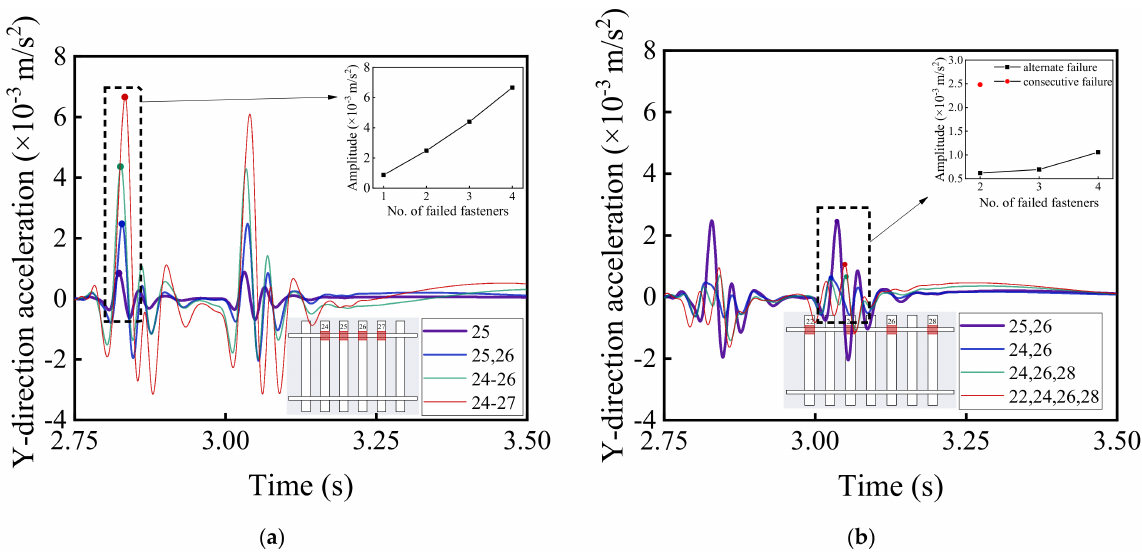
Figure 17. Model-calculated time history curves of lateral (Y-direction) acceleration response of car bodies with ( a ) single-side consecutive and ( b ) single-side alternate fastener